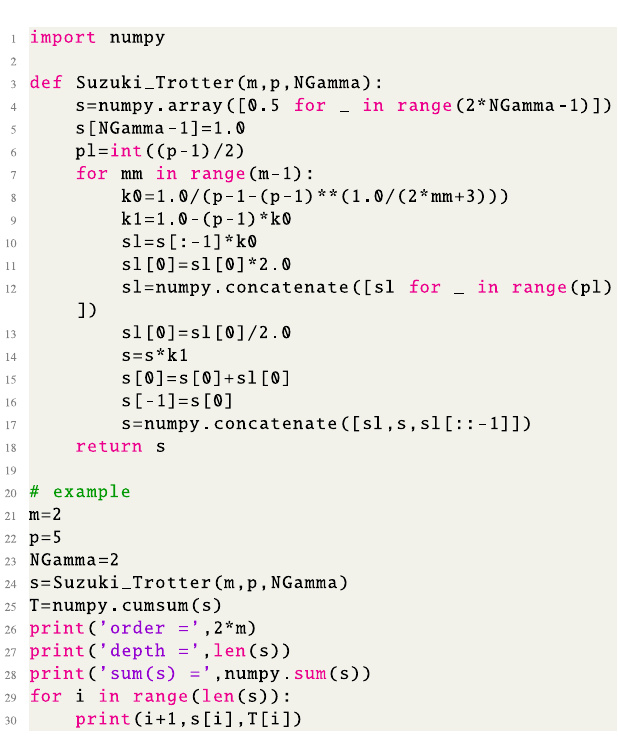
FIG. 15. Same as Fig. 6 but for the Fermi-Hubbard model with U H / J = 4 at half filling.